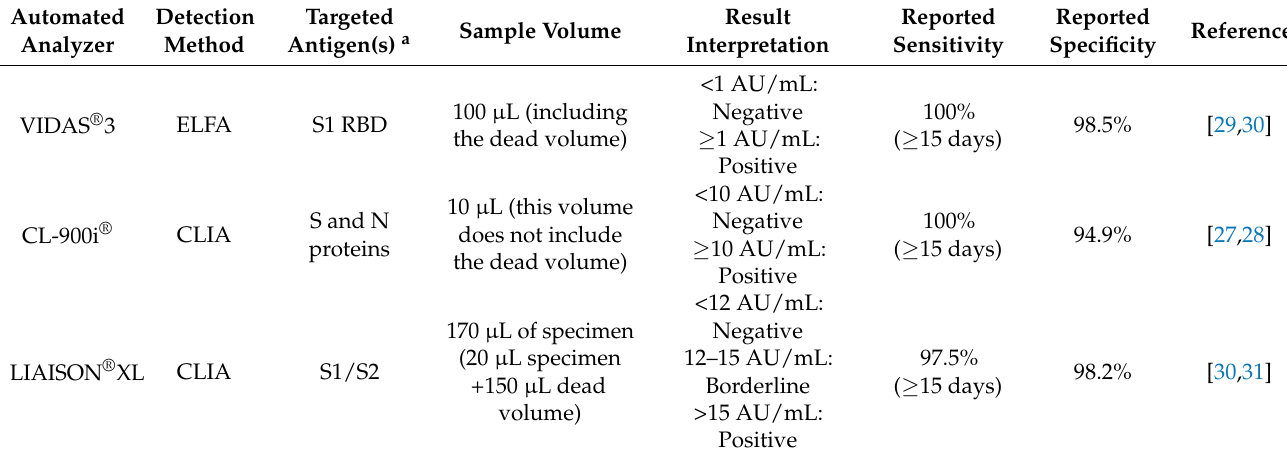
Table 1. Characteristics of the automated analyzers used for SARS-CoV-2 IgG antibodies